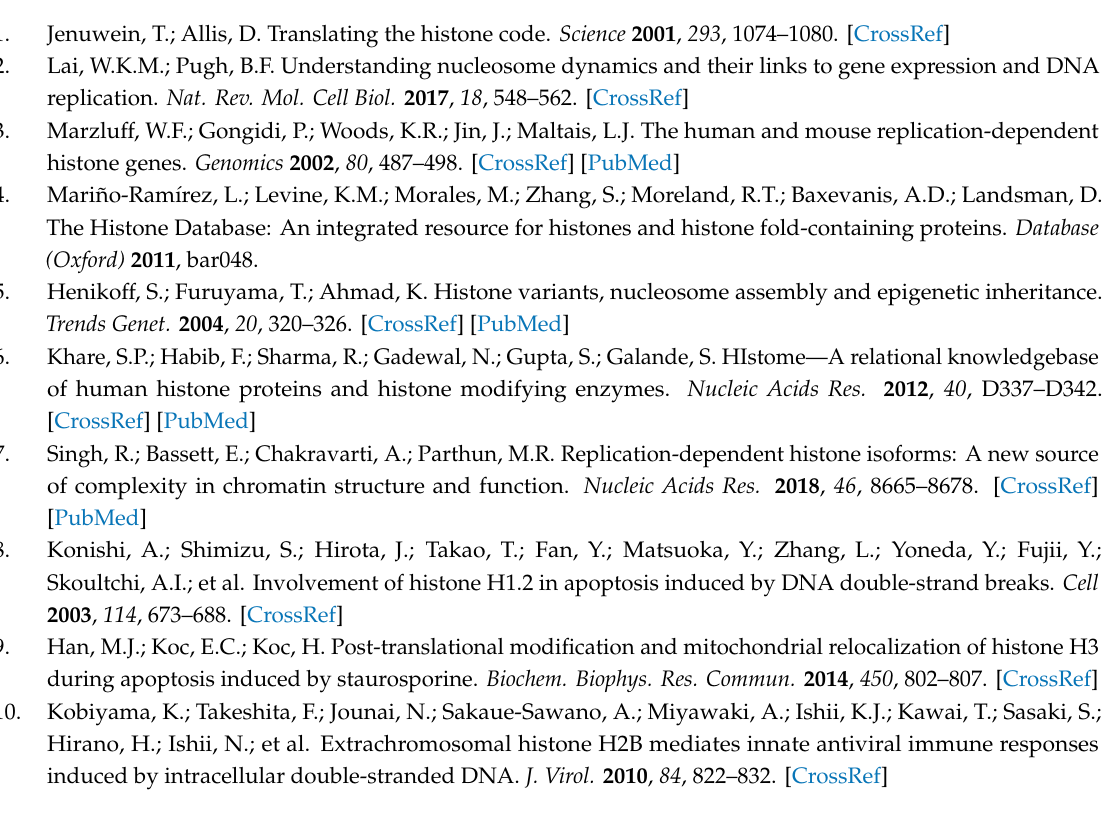
Figure S1: ecH2B depletion in HeLa cells, Figure S2: ecH2B depletion in HFs induces cytokinesis defects comparable to those observed in HeLa cells, Figure S3: Depletion of ecH2B with single variant specific siRNAs, Figure S4: HIPK2-mediated phosphorylation of H2B, Figure S5: Colocalization of H2B-S14 P and CHMP4B, Figure S6: ecH2B contributes to abscission site, Table S1: List of commercially available H2B variant-specific stealth RNAi used to perform the RNA interference, Table S2: List of antibodies with the relative IF conditions, Video S1: Time-lapse microscopy of CTRi HeLa cells related to Figure 4, Video S2: Time-lapse microscopy of H2Bi HeLa cells related to Figure